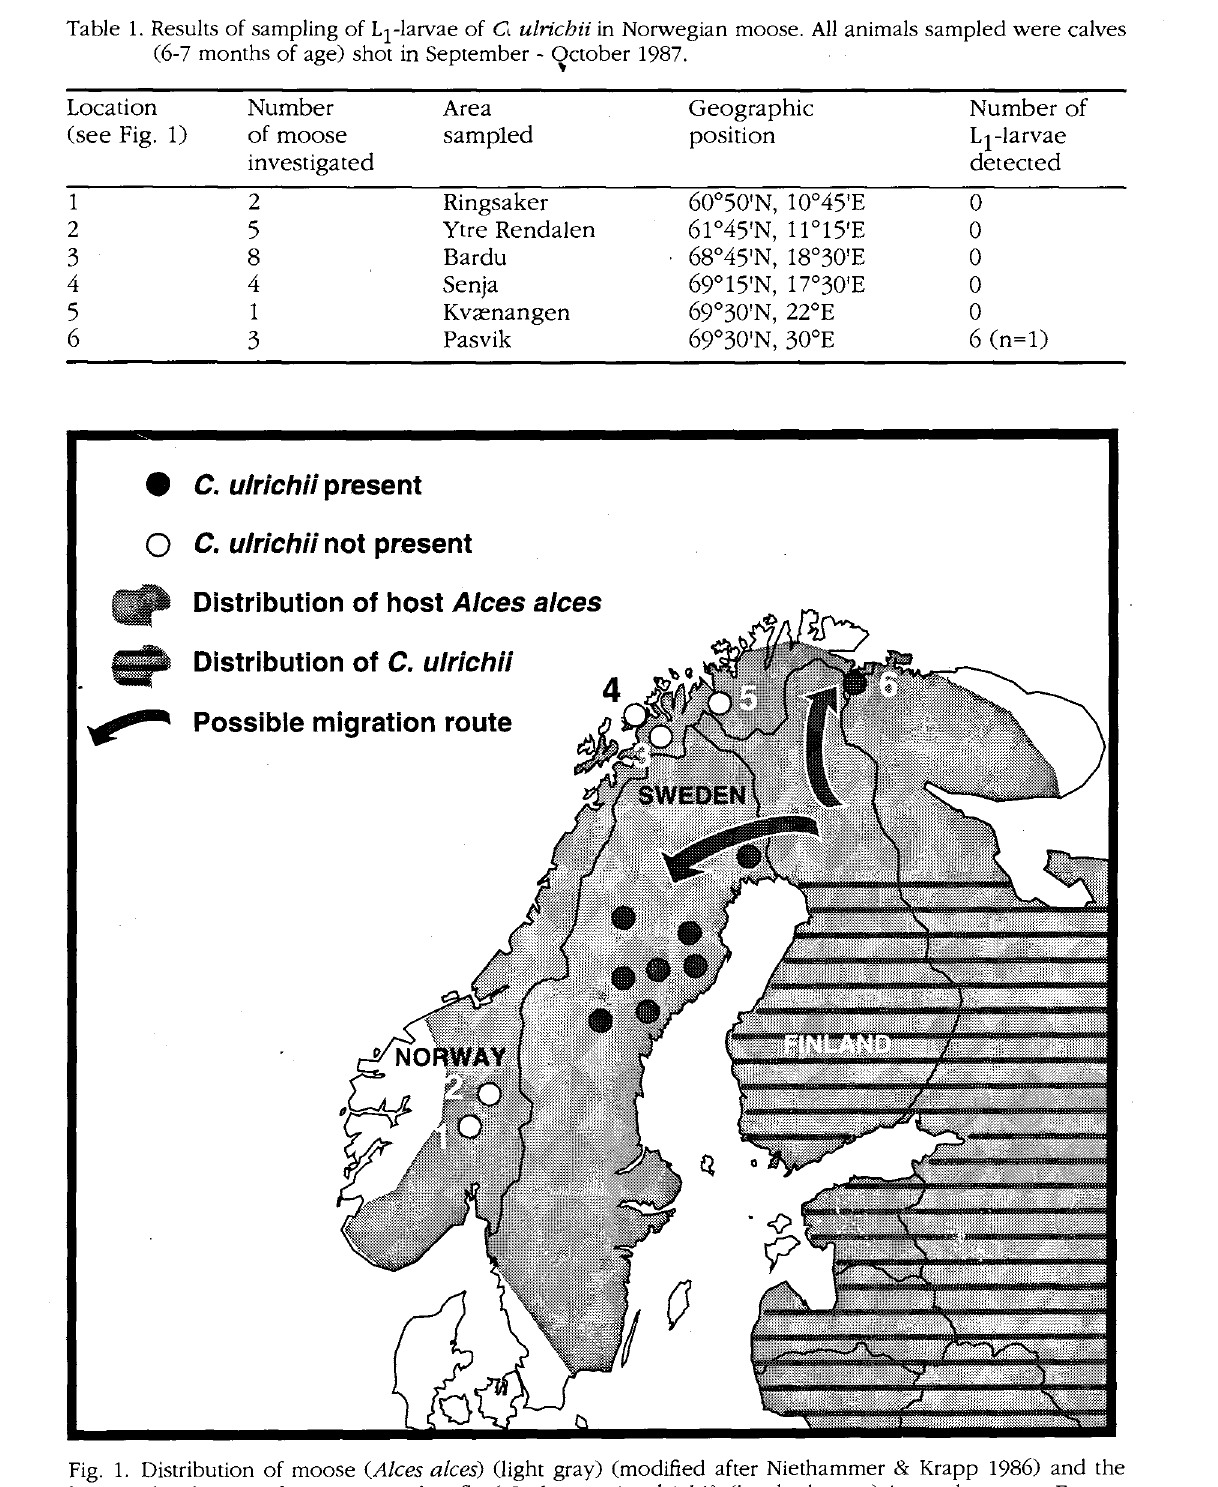
Table 1. Results of sampling of Lj-larvae of C. ulrichii in Norwegian moose. All animals sampled were calves (6-7 months of age) shot in September - October 1987.